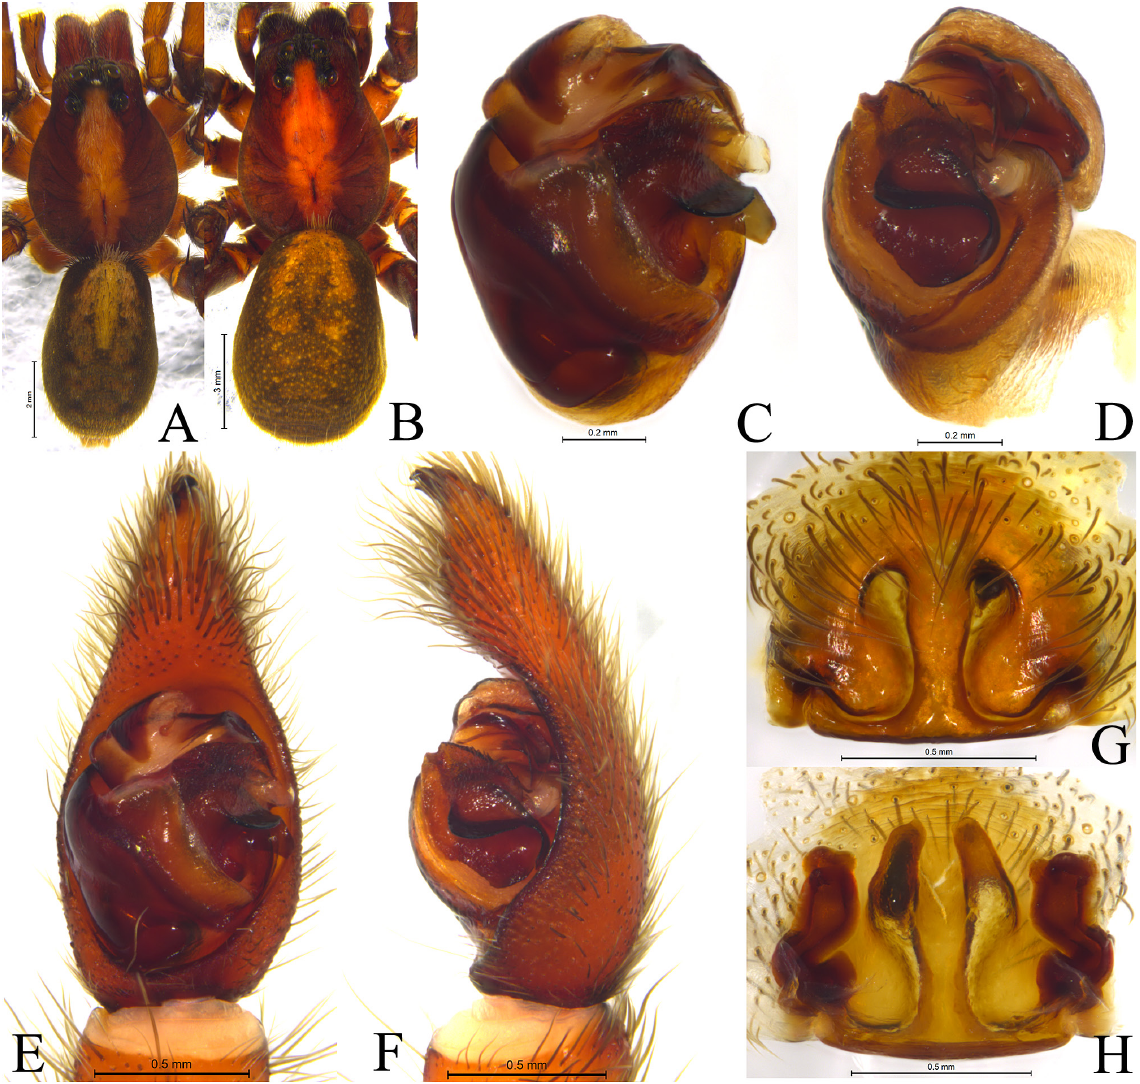
Fig. 5. Serratacosa multidontata (Qu, Peng & Yin, 2010) comb. nov. A . Holotype, ♂ (HNU). B . Paratype, ♀ (HNU). C–F . Paratype, ♂ (HNU). G–H . Paratype, ♀ (HNU). A . Male habitus, dorsal view. B . Female habitus, dorsal view. C . Left pedipalp, bulbus, ventral view. D . Left pedipalp, retrolateral view. E . Left pedipalp, ventral view. F . Left pedipalp, retrolateral view. G . Epigyne, ventral view. H . Vulva, dorsal